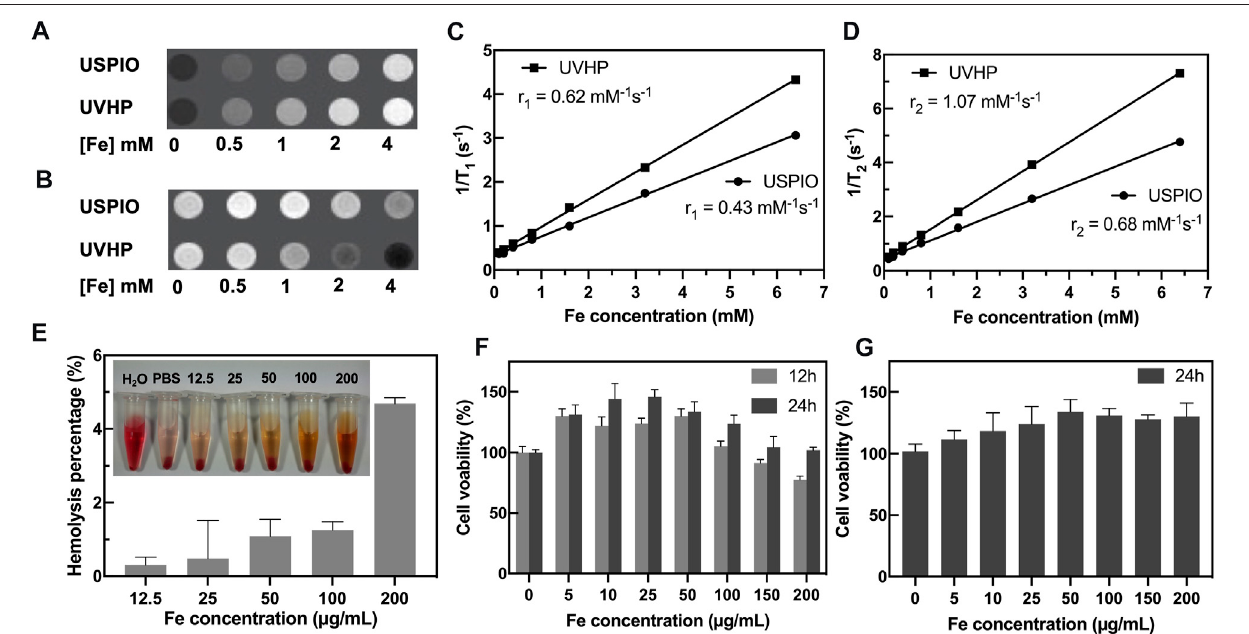
FIGURE 3 | MRI scans and cytotoxicity assay of UVHP. T 1 -weighted (A) and T 2 -weighted (B) images of UVHP aqueous solution at different Fe concentrations (0, 0.5,1,2,and4 mM)takenbya3.0-TclinicalMRIsystemunderthefollowingparameters:FOV=100 mm;matrix=168×168;sectionthickness=2 mm;TR=2,000 ms; TE=60 ms.USPIOwasusedascontrol. (C,D) Plotof1/T 1 and1/T 2 overFeconcentrationofUVHP,theslopeindicatesthespeci fi crelaxivity( r 1 and r 2 ).USPIOwasused ascontrol. (E) ThehemolysisassayofUVHP(Feconcentration12.5,25,50,100,200 µg/mL).PBSandwaterwereusedasnegative andpositivecontrols. (F) The viabilityofRAW 264.7cellsafter coculturewithUVHPatdifferentFeconcentrationsfor12or 24 hwasmeasured bytheCCK8 assay.RAW 264.7cellstreatedwithPBS wereusedascontrol,respectively. (G) TheviabilityofHFLS-RAcellsaftercoculturewithUVHPatdifferentFeconcentrationsfor24 hwasmeasuredbytheCCK8assay. HFLS-RA cells treated with PBS were used as control,